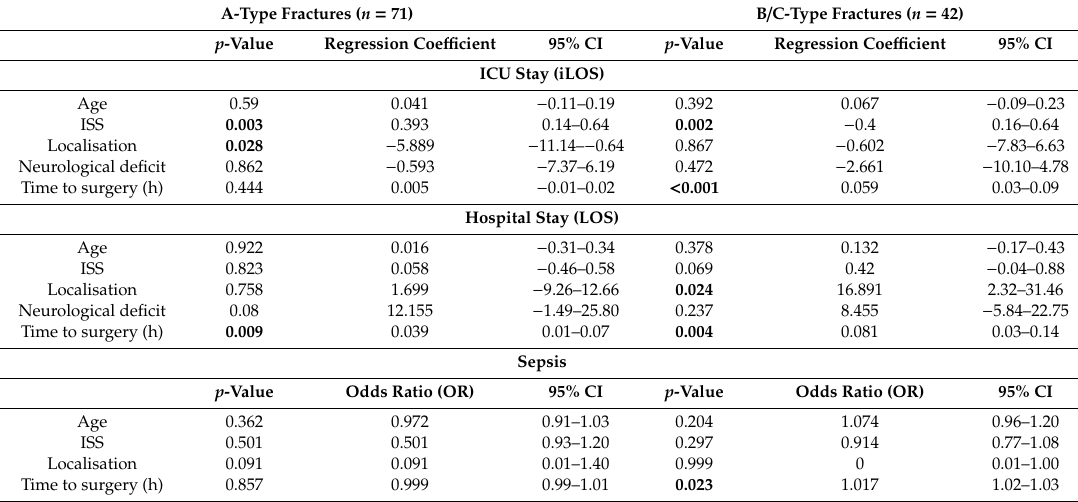
Table 8. Regression analysis for A and B- / C-type fractures with the dependent variables: LOS (days), iLOS (days), and sepsis.